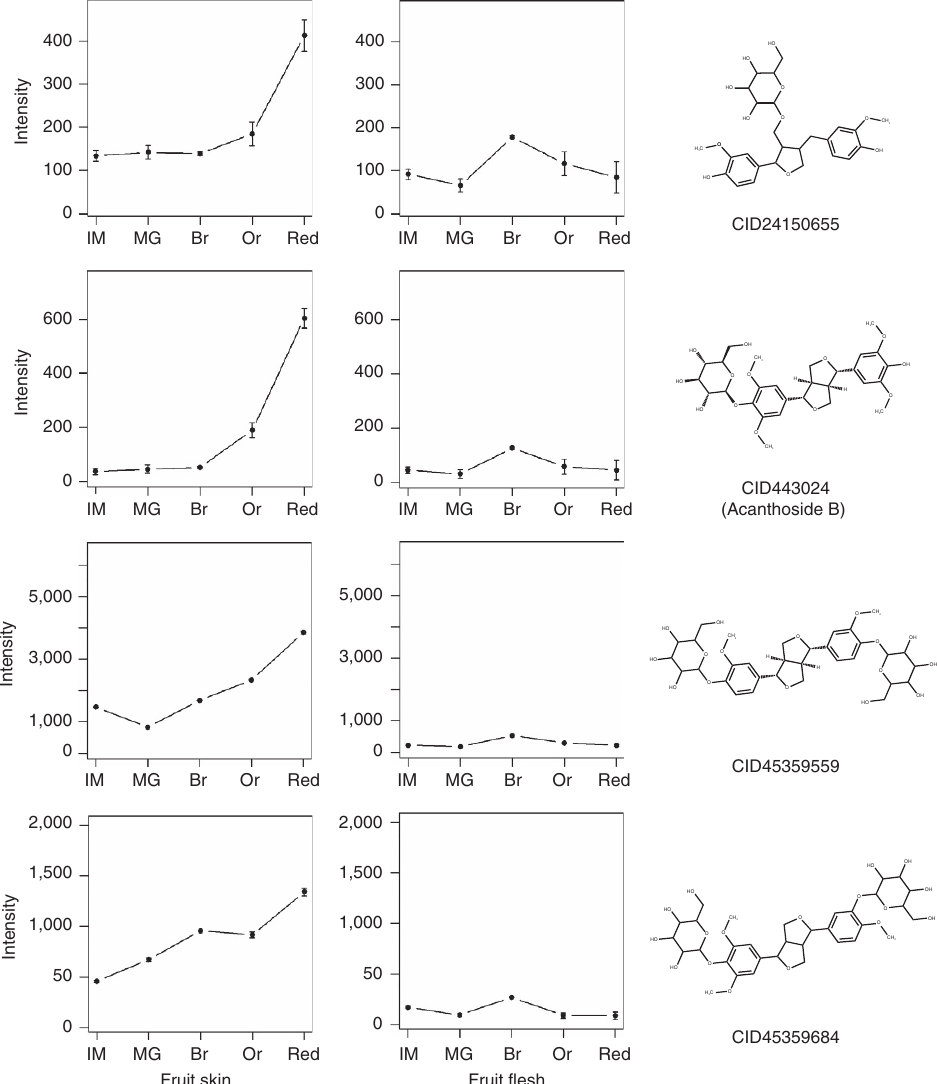
Figure 5 | Accumulation of lignans during tomato fruit development in skin and flesh tissues. Five developmental stages of tomato fruit: immature green (IG); mature green (MG); breaker (Br); orange (Or); and red (Red), are denoted on the x axis, related to fruit skin (left plots) and fruit flesh (right plots). The mean values of LC–MS peak intensities are denoted on the y axis, along with error bars denoting the s.e.m. (three biological replicates). The identified lignans show peaks of accumulation during the red fruit ripening stage in the fruit skin tissue, while levels of these lignans are relatively lower along all stages of fruit development in the fruit flesh